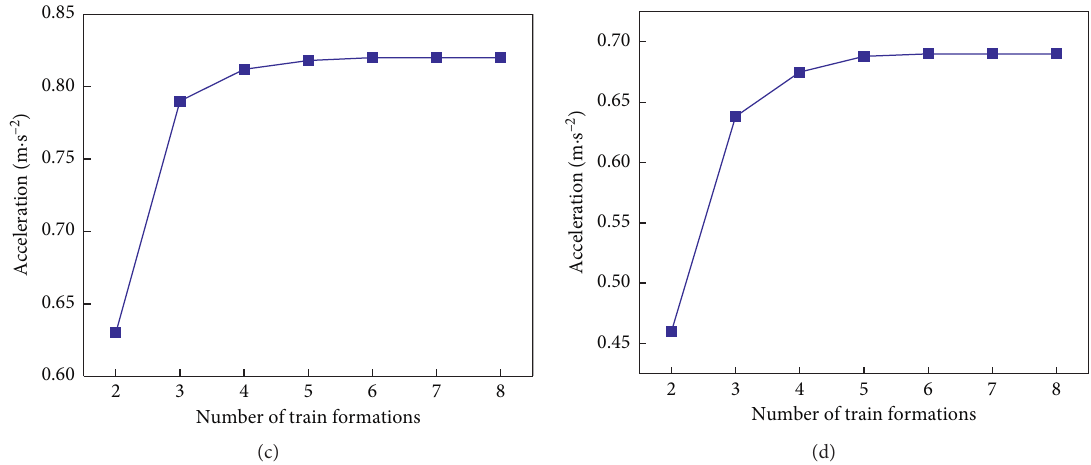
Figure 15: Maximum DR of the bridge girders’ mid-span section with different numbers of train formations: (a) vertical deflection; (b) strain; (c) vertical acceleration; (d) lateral acceleration.